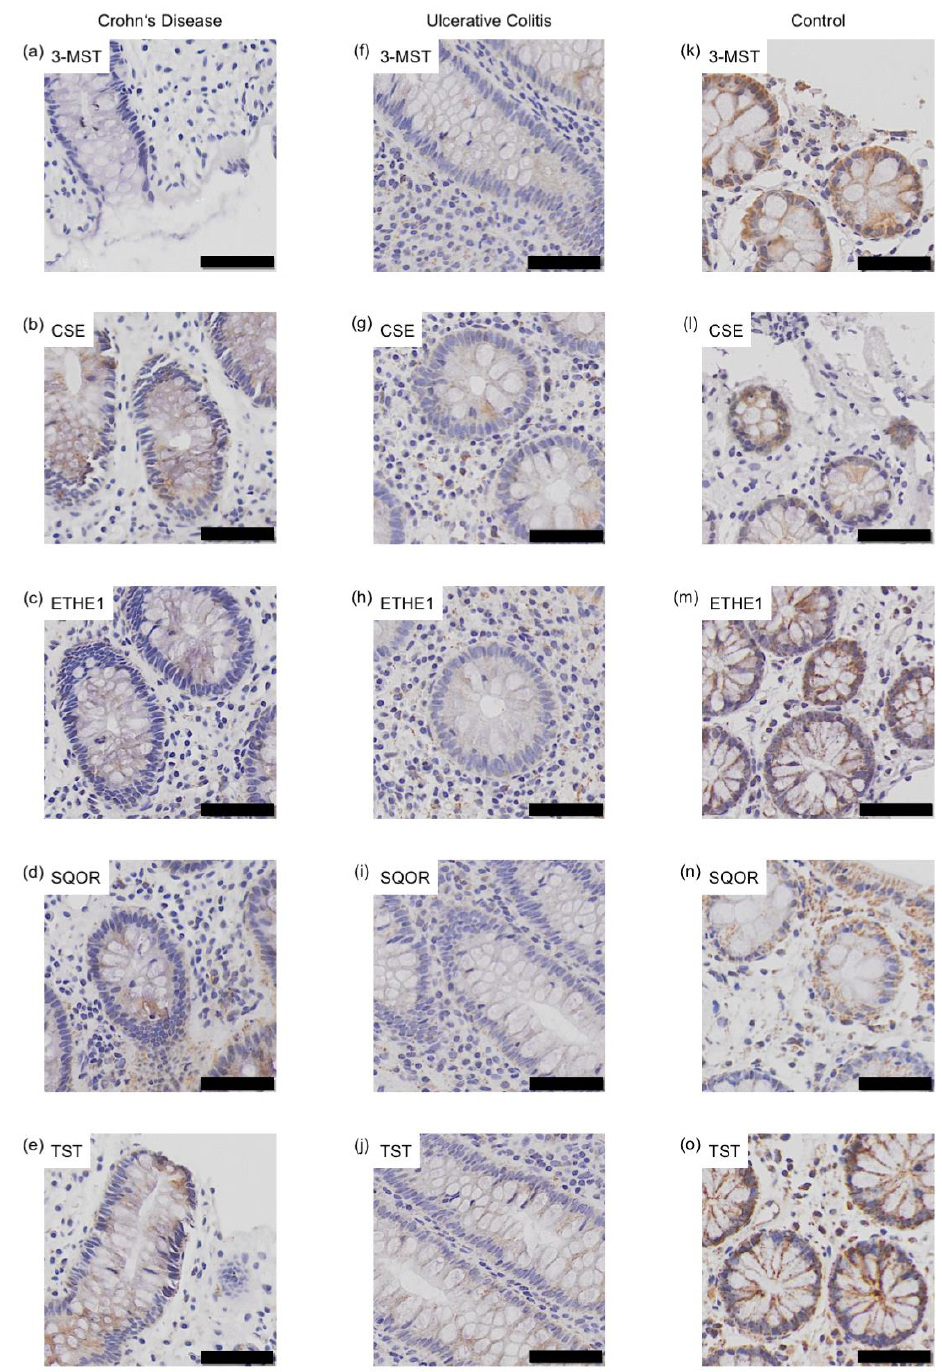
Figure 7. Immunohistochemical staining of 3-mercapto-sulfurtransferase (3-MST) ( a , f , k ), cystathionine- γ -lyase (CSE) ( b , g , l ), ethylmalonic encephalopathy 1 protein (ETHE1) ( c , h , m ), sulfide:quinone oxidoreductase (SQOR) ( d , i , n ) and thiosulfate sulfurtransferase (TST) ( e , j , o ) in the ascending colon of an adult Crohn’s disease (CD) patient (case number: 1593; a – e ), ulcerative colitis (UC) patient (case number: 118884; f – j ) and a healthy control (case number: 14411; k – o ). Scale bar: 50 μ m.